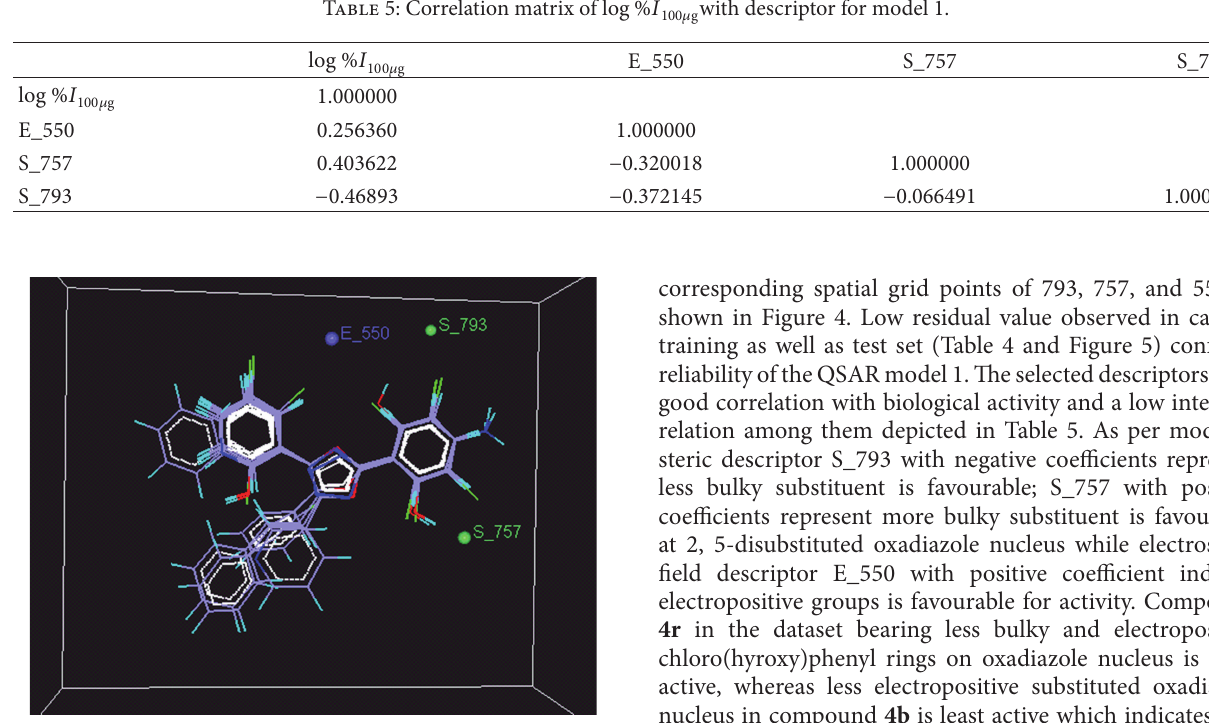
F 4: 3D QSAR model spatial grid points.